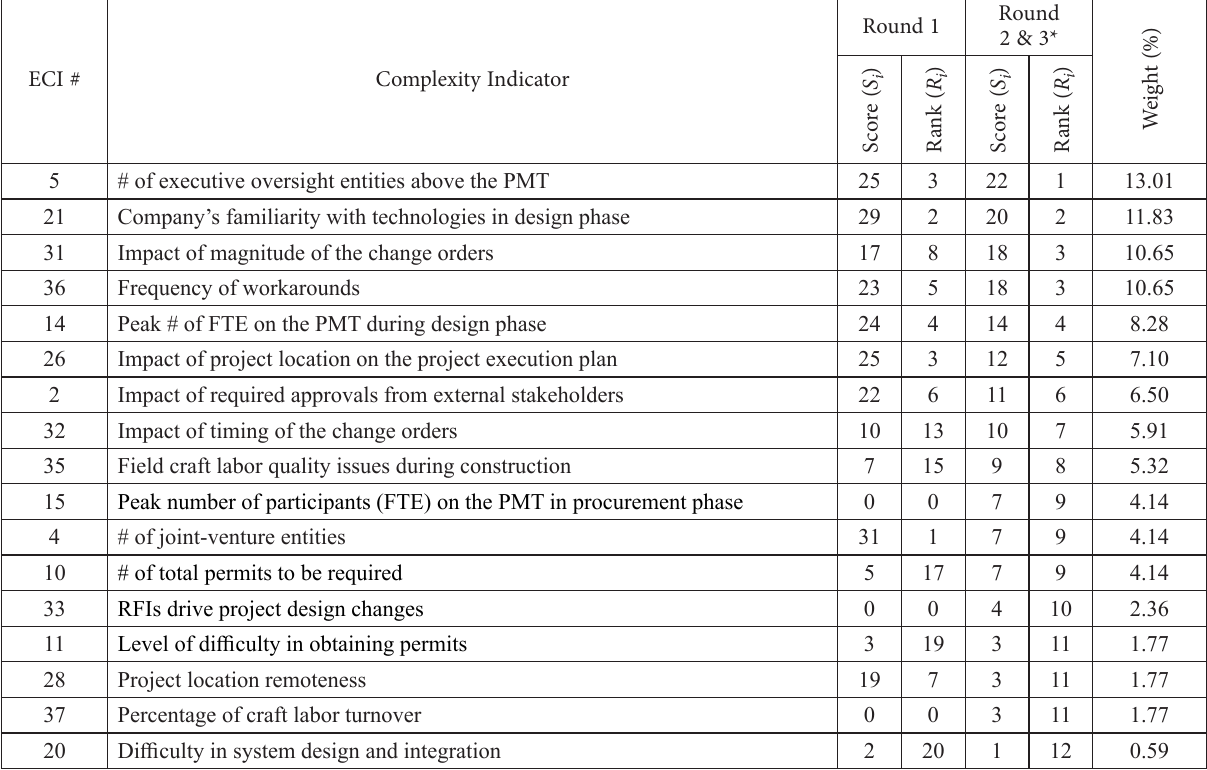
Table 4. Identified complexity indicators corresponding to owner’s perspective, ranking, and weighting of them